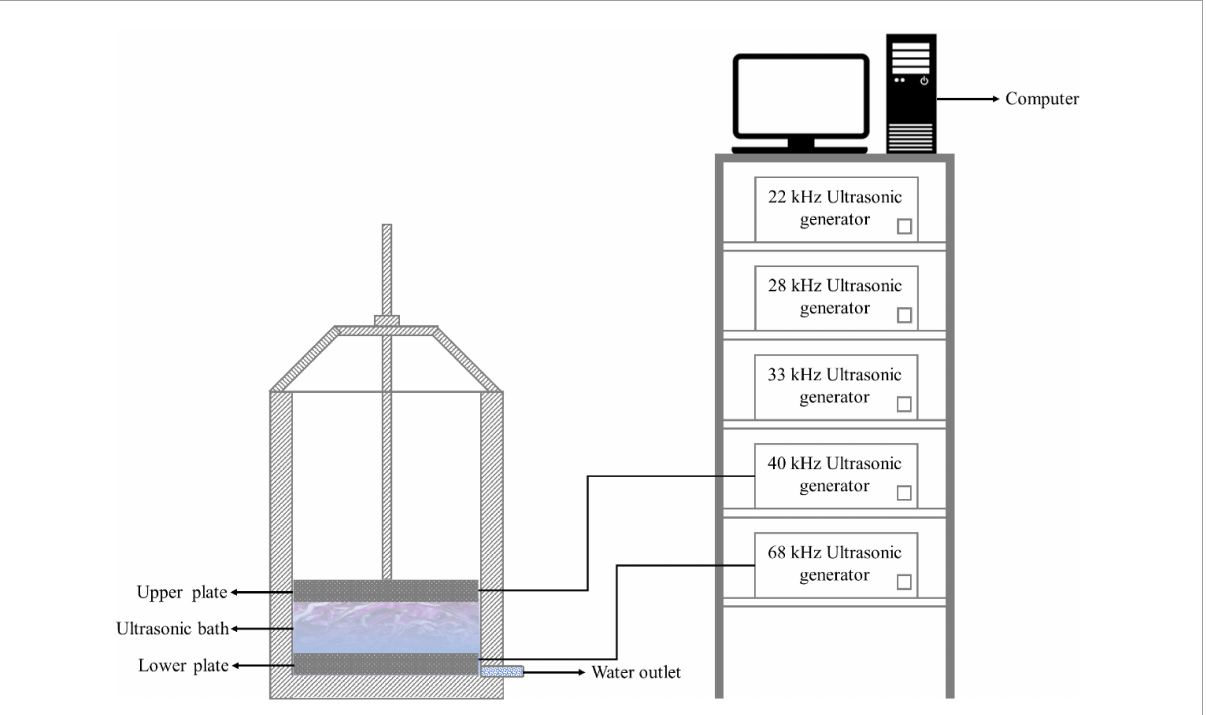
FIGURE1 Schematic diagram of the flat-plate ultrasound